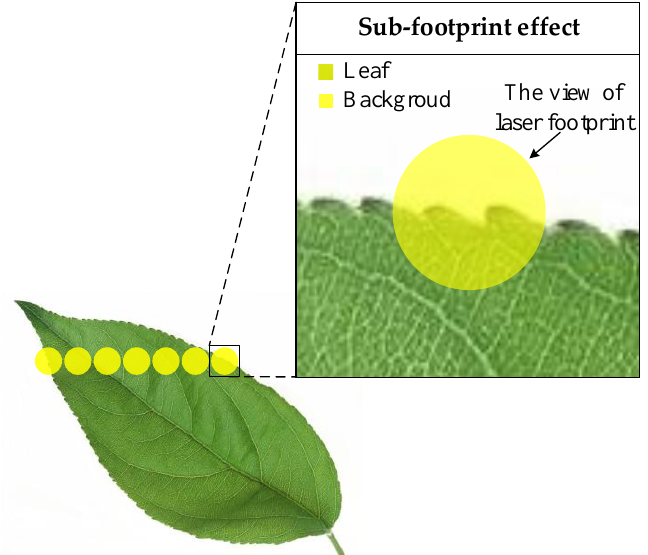
Figure 1. Illustration of the sub-footprint effect. The laser beam is emitted by a supercontinuum laser with a 3 mrad divergence angle.